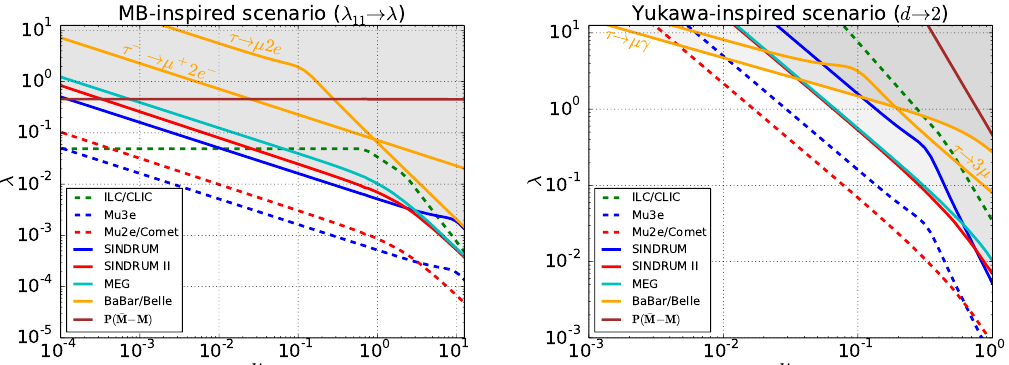
Figure 1: Limits on λ and ν from various processes, using λ D (right panel) of(6) with m